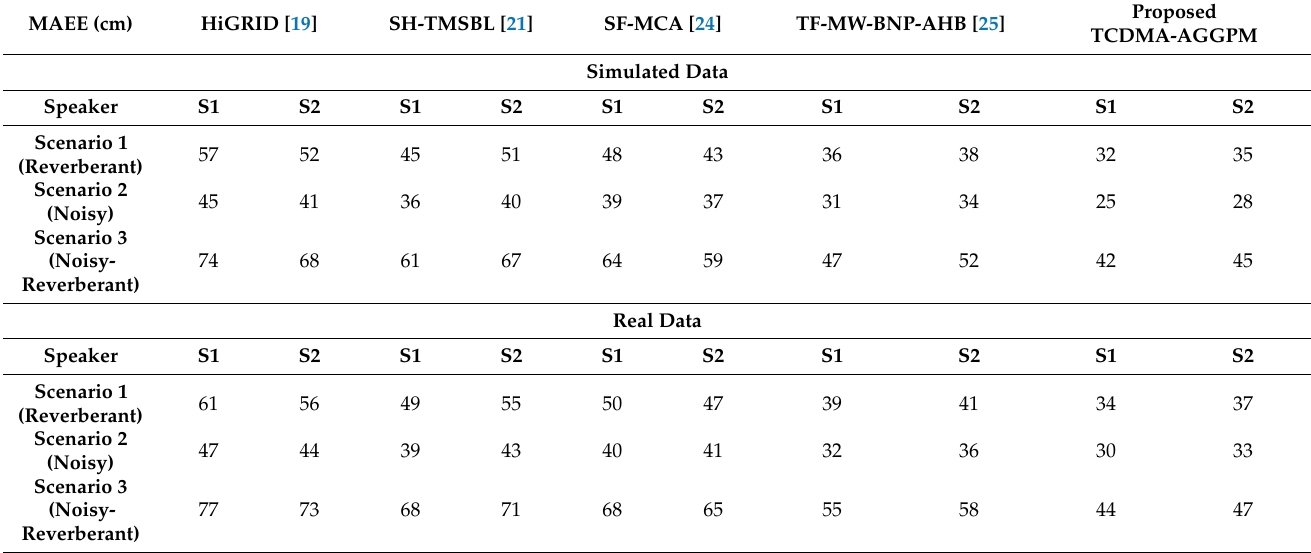
Table 2. The MAEE results (in cm) for the proposed TCDMA-AGGPM algorithm in comparison with HiGRID, SH-TMSBL, SF-MCA, and TF-MW-BNP-AHB methods on real and simulated data, for 2 simultaneous speakers and for reverberant (scenario 1), noisy (scenario 2), and noisy-reverberant (scenario 3)